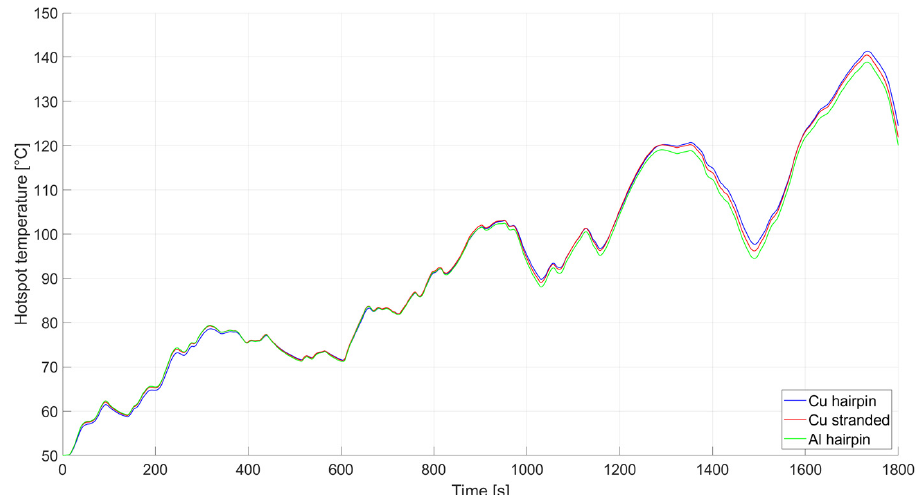
Figure 13. Hotspot temperatures in WLTP class 3 drive cycle. Figure 12. Stator winding losses in the WLTP class 3 drive